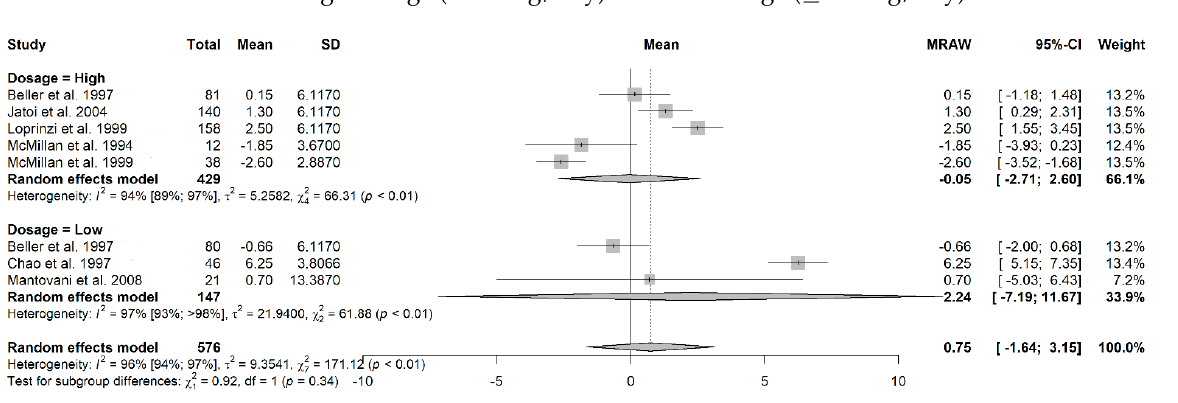
Figure 2. The forest plot showing the pooled mean change in weight for patients who received